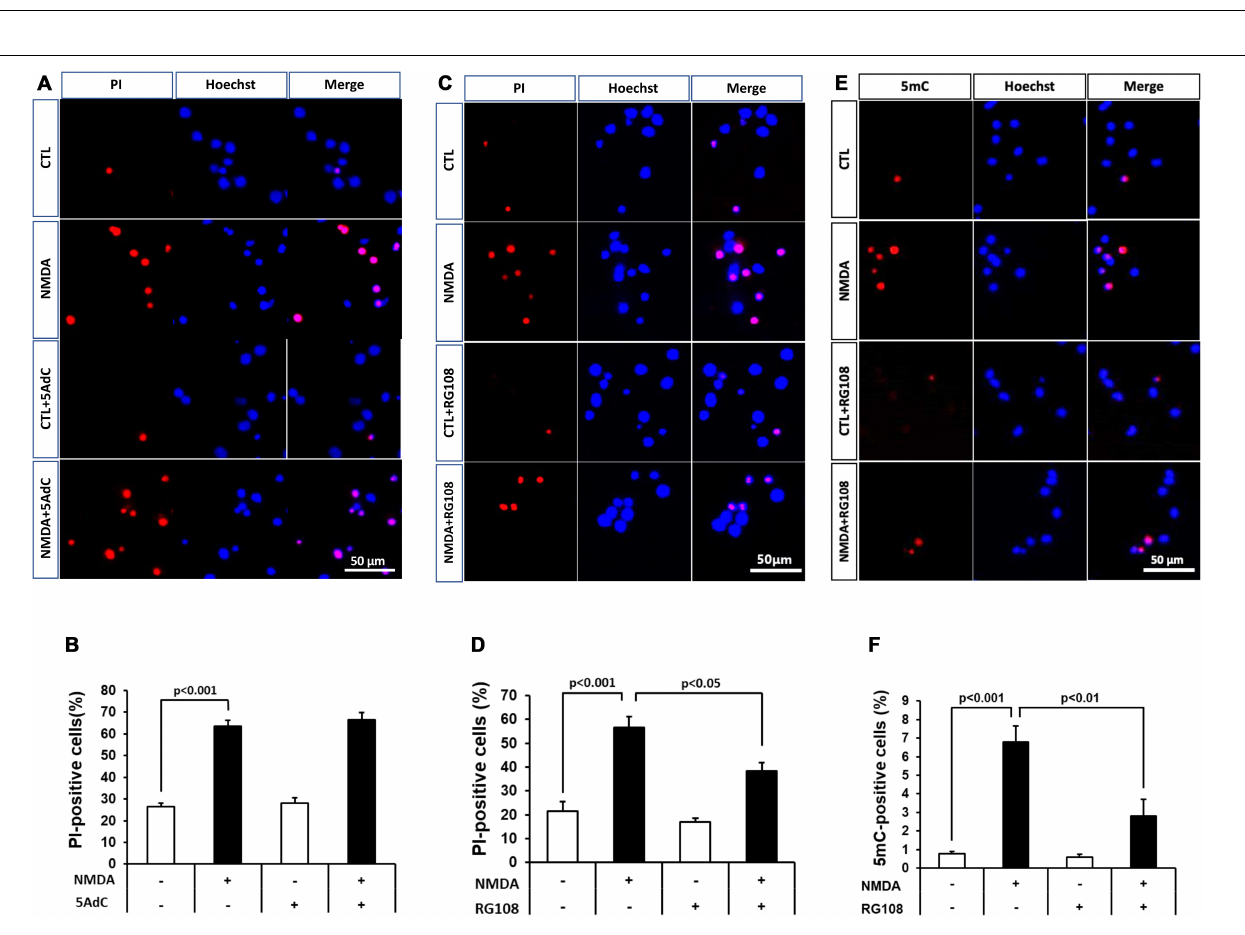
FIGURE 6 | (A,C) Effects of DNMT inhibitors 5AdC (10 µ M; A ) and RG108 (100 µ M; C ) on NMDA-induced cell injury. Representative images of PI staining are shown. The scale bar indicates 50 µ m. (B,D) PI-positive cells were counted as dead cells and are shown as the ratio to total cells (Hoechst-positive cells). Counted cell number was 933–1,697 (B) and 736–1,087 (D) in each well. (E,F) Effects of DNMT inhibitor RG108 (100 µ M) on NMDA-induced DNA methylation 30 min after start of treatment. (E) 5mC-positive cells were counted and are shown as the ratio to total cells (Hoechst-positive cells). Counted cell number was 731–1,049 (F) in each well. The scale bar shows 50 µ m. Images of random four areas (each area of 1.3 mm 2 ) of each well were taken. Results are the means ± SD ( n = 4–5 independent experiments). PI, propidium iodide; CTL, control